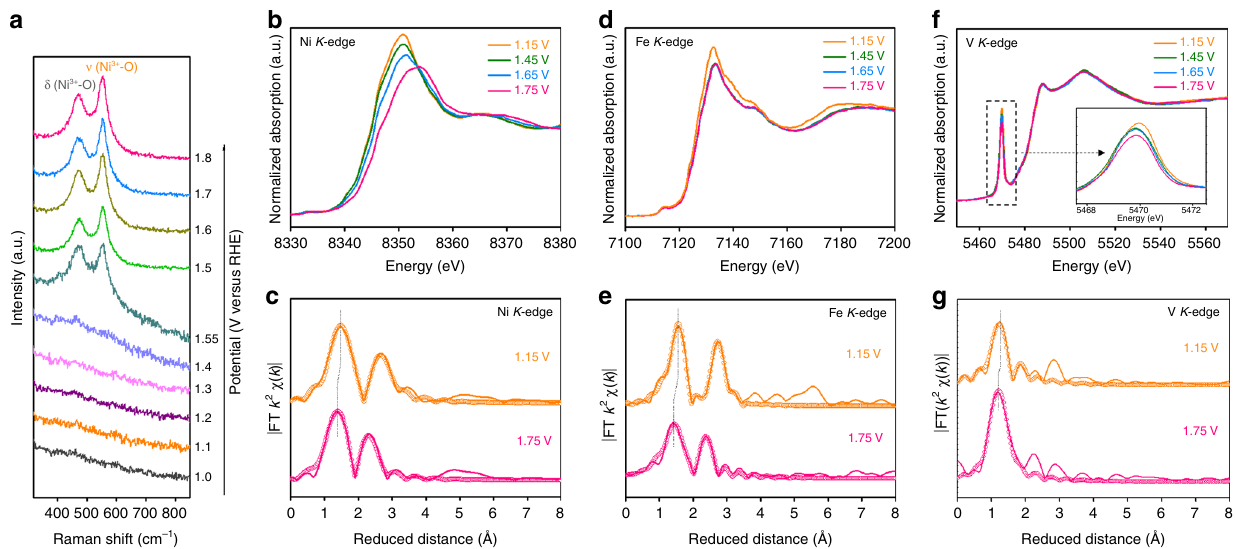
Fig. 6 In-situ EC-Raman and hard XAS spectra. a In-situ EC-Raman spectra of Ni 3 Fe 0.5 V 0.5 at the potentials of 1.0 – 1.8 V in 1 M KOH. b , d , f In-situ Ni, Fe, and V K -edge XANES spectra at the potentials of 1.15 – 1.75 V. c , e , g FT curves of Ni, Fe, and V K -edge EXAFS k 2 χ ( k ) functions obtained from the XANES spectra in b , d , f , respectively. The orange and pink circles represent the fi tting